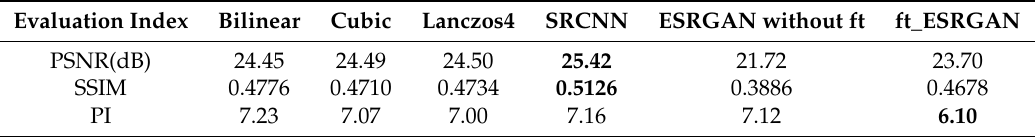
Table 2. The average Peak Signal-to-Noise Ratio (PSNR), structural similarity index (SSIM) and perceptual index (PI) of SR images generated by different SR